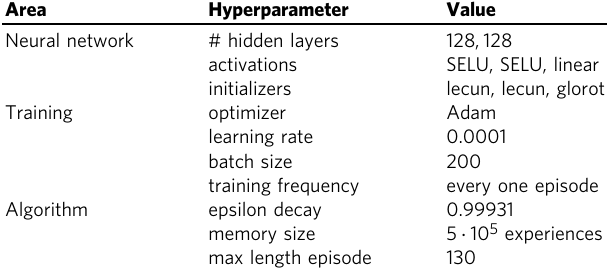
Table 4 List of the hyperparameters and their values used in the Harrow – Recht – Chuang ef fi cient base of gates (HRC) problem. The deep Q-learning agent employs scaled exponential linear units (SELU) as nonlinear activation functions in the hidden layers of the neural network.